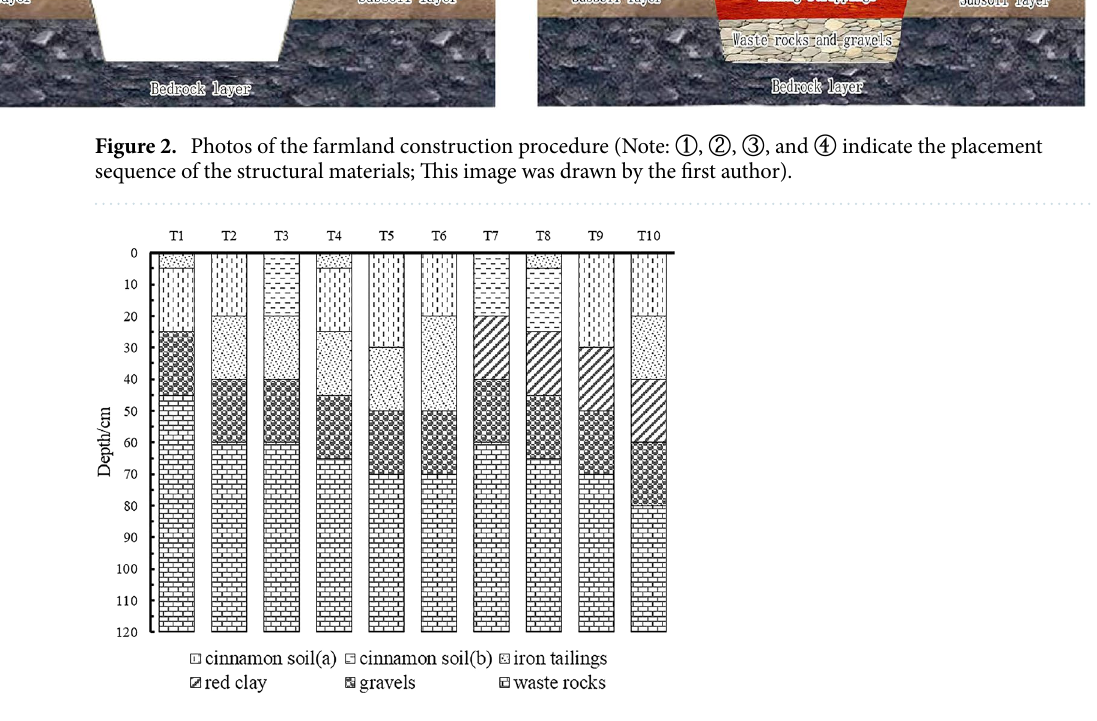
Figure 3. Schematic diagram of the soil profiles under the different farmland construction